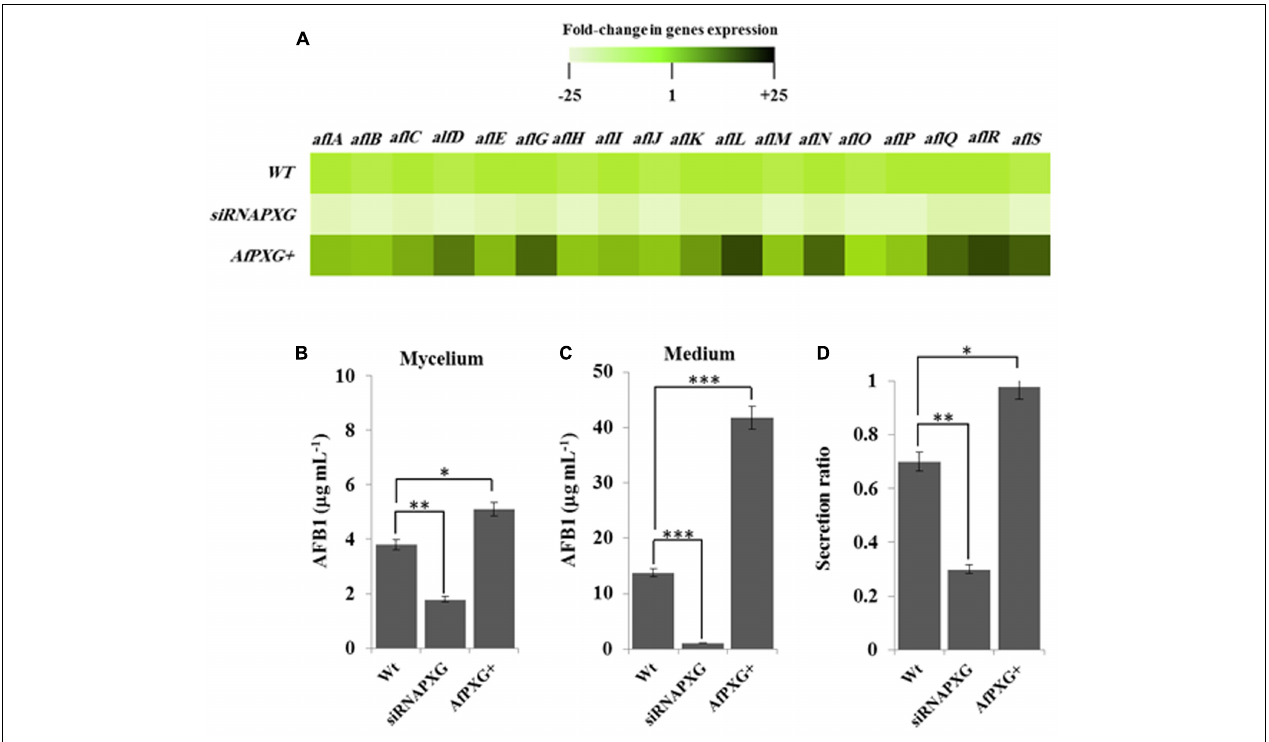
FIGURE 4 | The increased lipid droplet (ILD)-phenotype in A. flavus AfPXG+ is positively correlated with biosynthesis and secretion of AF. (A) Transcripts levels of the AFB1-biosynthesis genes in fungal tissue of the A. flavus AfPXG+ line compared with AfPXG2 -silenced and WT lines were evaluated by qRT-PCR. Three measurements were taken in three cDNAs prepared from three individual fungal growth for each line. Each point was triplicated and the average of C T was taken. The relative quantification RQ =2 ( − (cid:49)(cid:49) C T ) of the target gene was calculated using installed software from an Applied Biosystems StepOne cycler, United States. The color scale (white–green–black) indicates relative changes of transcript abundance of − 25-, 1-, and + 25-fold, respectively. For each gene, the expression level in WT was defined as 1, and the corresponding abundance changes under treatments were calculated directly using the software installed in the Applied Biosystems qPCR system. (B,C) Quantification of AFB1 production in the fungal mycelium and in the culture medium of A. flavus AfPXG + line compared with AfPXG2 -silenced and WT lines. (D) Secretion ratio of AFB1 by the three fungal lines (calculated as ratio of AFB1 in the medium to AFB1 in medium plus mycelia in a 100 mL culture). All measurements were performed in triplicate and the presented data are means ± SD ( n = 3). The differences in AF production between lines were significant when analyzed by t -test ( ∗ P < 0.05; ∗∗ P < 0.01; ∗∗∗ p <